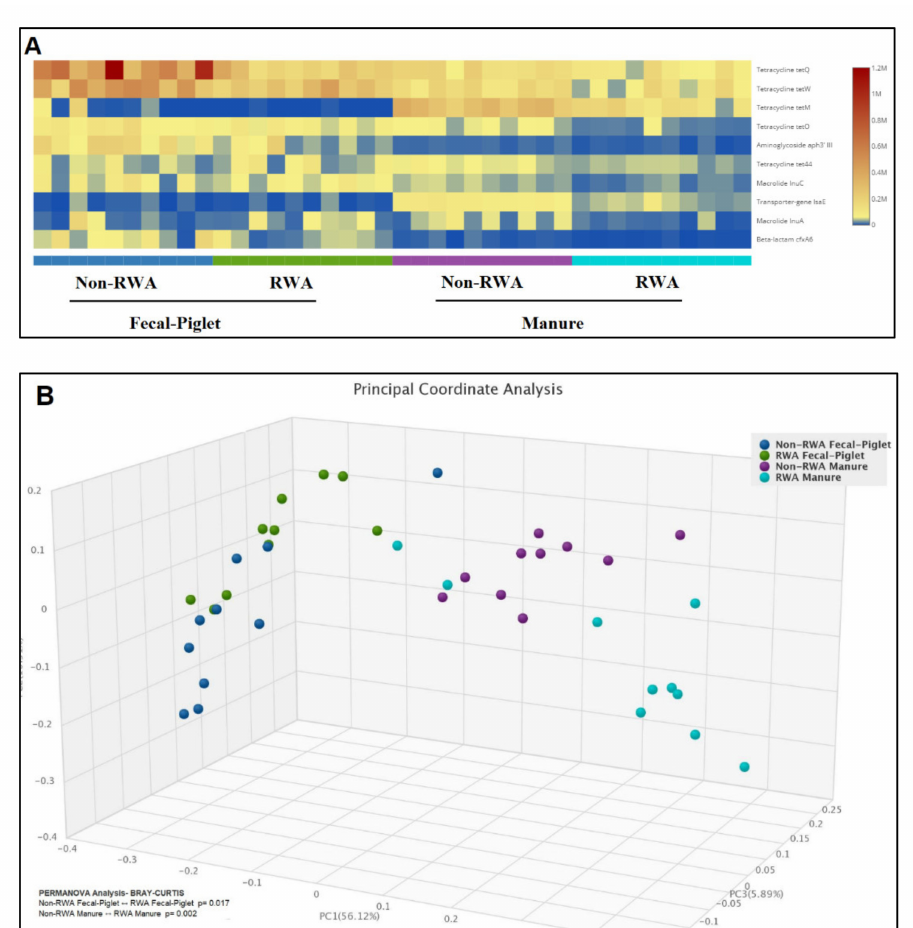
Figure 6. Gene frequency heat map comparative analysis of piglet feces and manure from non-RWA vs. RWA barns, showing the frequencies of the 10 most abundant ARG taxa ( A ). PCoA and ordination permANOVA analysis of the non-RWA vs. RWA resistome profiles from piglet-fecal and manure samples ( B